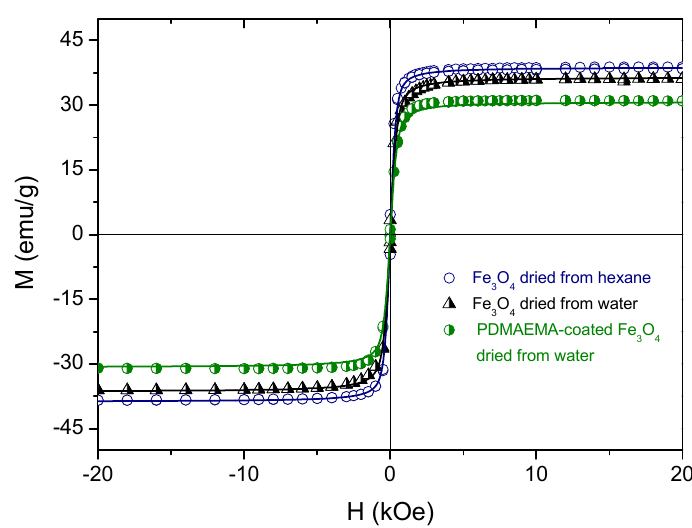
Figure 11. Magnetization curves of bare and coated magnetite nanoparticles. The lines are the best fits to the Langevin equation.